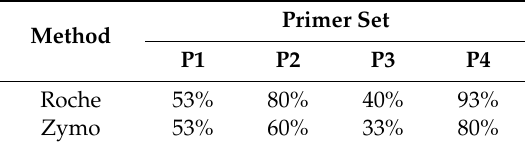
Figure 4. Comparison of DNA yield extracted from clinical (sputum) samples using the Roche and Zymo protocols. Sputum samples were split into two aliquots and subjected to both extraction methods. Resultant DNA was quantified using a qubit fluorometer. The p -value for a Mann–Whitney U test of di ff erences between methods is indicated, suggesting greater DNA extraction e ffi ciency of the Zymo kit. Table 3. Success rate of ITS band amplification from COPD sputum samples ( n = 15) using di ff erent DNA extraction techniques and primer sets. ROCHE: Roche High Pure PCR Template Preparation Kit. ZYMO: Quick-DNA ™ Miniprep Plus Kit. P1: ITS1F and ITS2. P2: ITS1-30F and ITS1-217R. P3: gITS7ngs and ITS4ng. P4: Fseq and